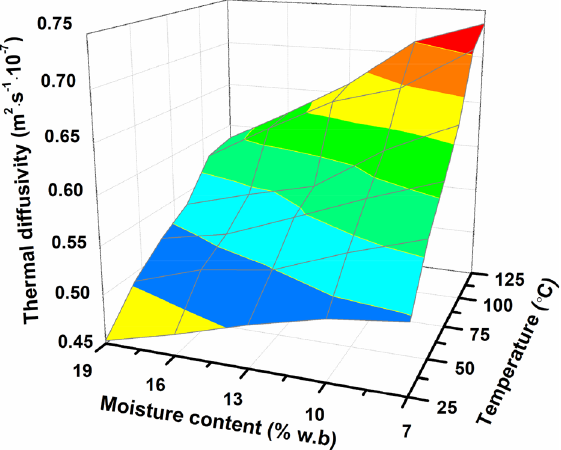
Figure 9. Thermal diffusivity ( α ) of grinded Cassia tora L. seeds affected by moisture